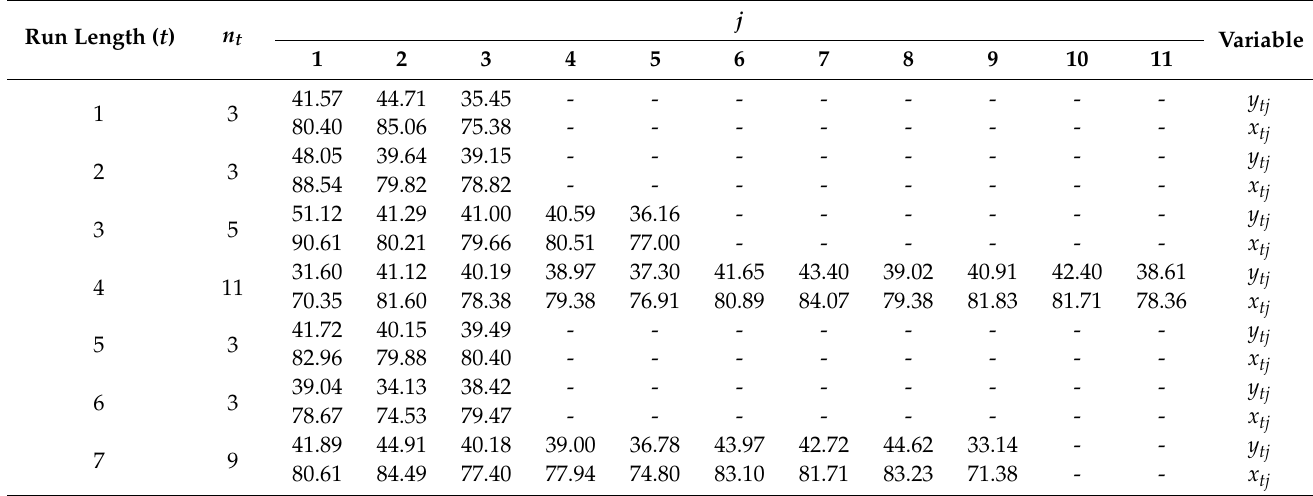
Table 6. The response and explanatory variables of the generated profiles in the illustrative example (the first five profiles are in-control).